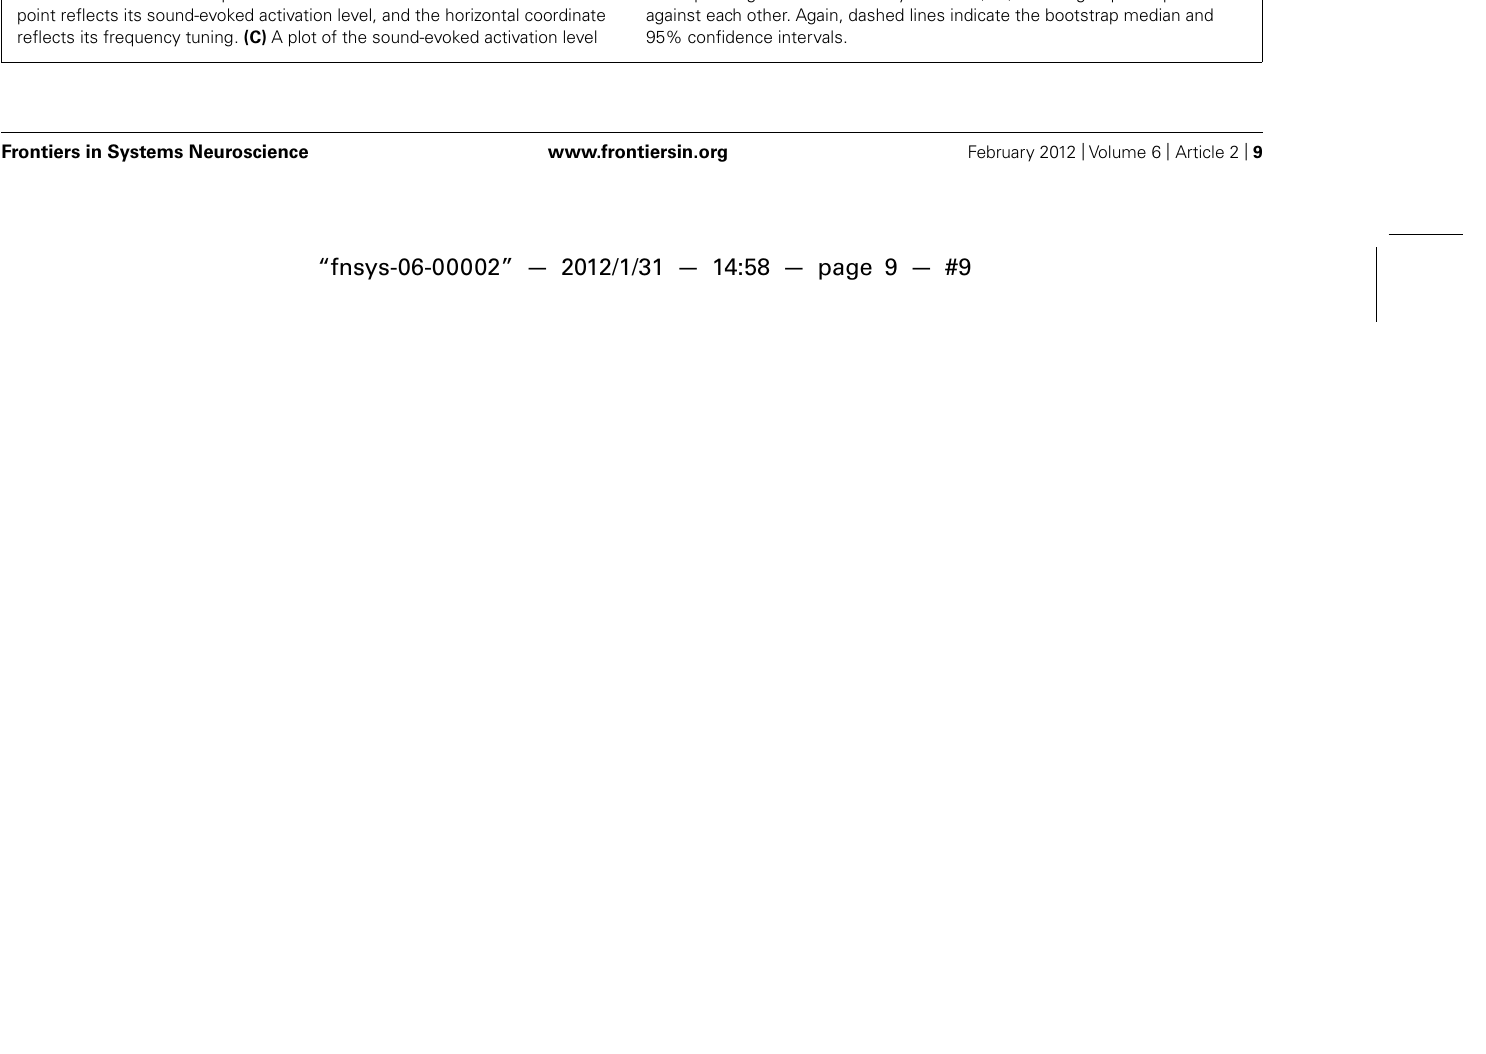
(top) and frequency tuning (bottom), as quantified by the value x 1 and ratio x 2 / x 1 , respectively, comparing healthy controls and tinnitus patients. (D) The probability density function (pdf) of the value x 1 (top) and ratio x 2 / x 1 (bottom) is plotted in the form of a histogram. Dashed lines indicate the median and 95% confidence intervals as obtained from a bootstrap procedure. (E) The corresponding cumulative density function (cdf) in both groups are plotted against each other. Again, dashed lines indicate the bootstrap median and 95% confidence